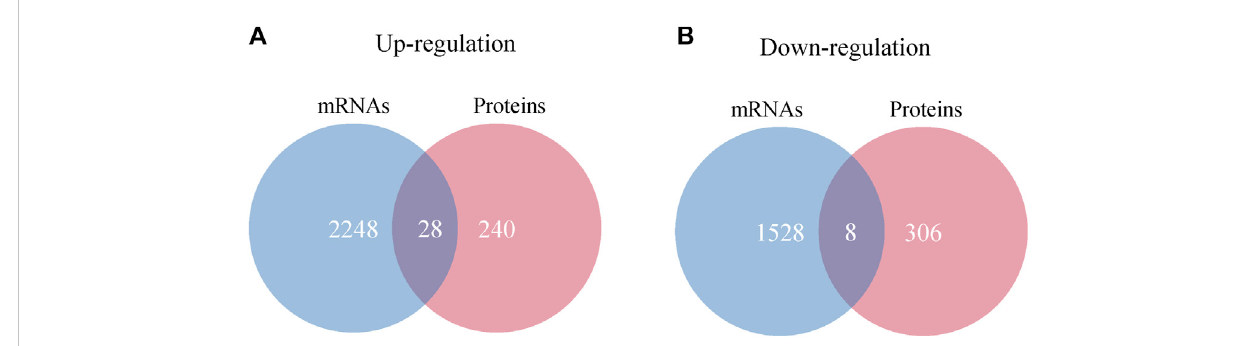
FIGURE 10 Interaction analysis of differentially expressed proteins and mRNAs. (A) Venn diagram of upregulated proteins and mRNAs. (B) Venn diagram of downregulated proteins and